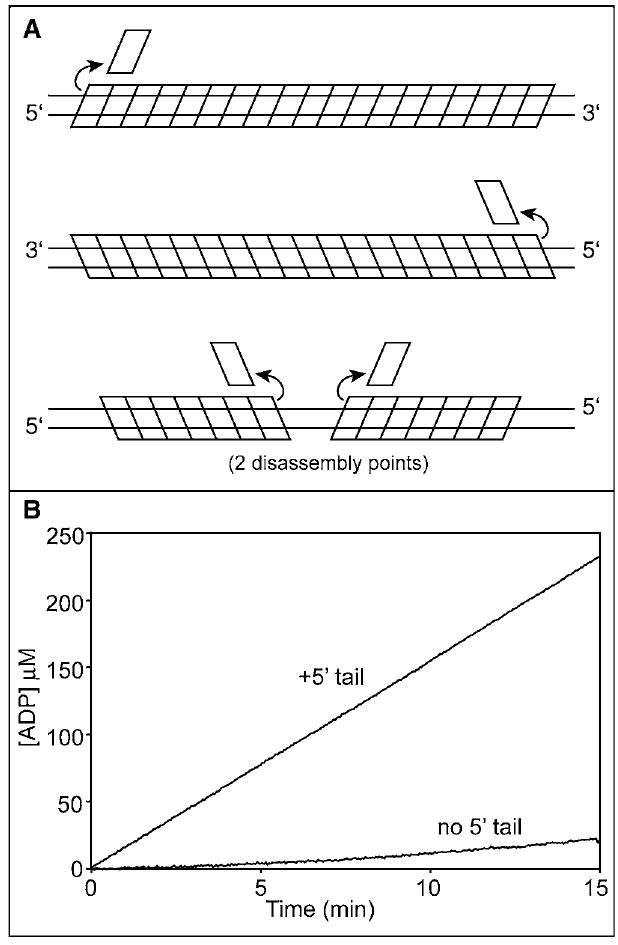
Figure 5. RecA Filament Formation on dsDNA (A) RecA filaments can nucleate on dsDNA so as to have two different orientations. The initiating strand guides the orientation of each filament, with its polarity labeled in each panel. If two nucleations occur on the same filament, there can be two independent disassembly points. (B) The effect of the 30-nt 5 9 extensions on RecA protein filament formation. Reactions contained 4 l M RecA protein, 4 l M DNA, and no SSB and were carried out at pH 6.6. The tailed DNA substrate has 2,900 bp of duplex DNA with the 30-nt 5 9 extension on one end. The completely duplex DNA is 3,162 nt in length. The enhanced nucleation afforded by these tails is evident in the rapid ATP hydrolysis seen when the tailed DNA is used as cofactor. DOI: 10.1371/journal.pbio.0030052.g005 PLoS Biology |